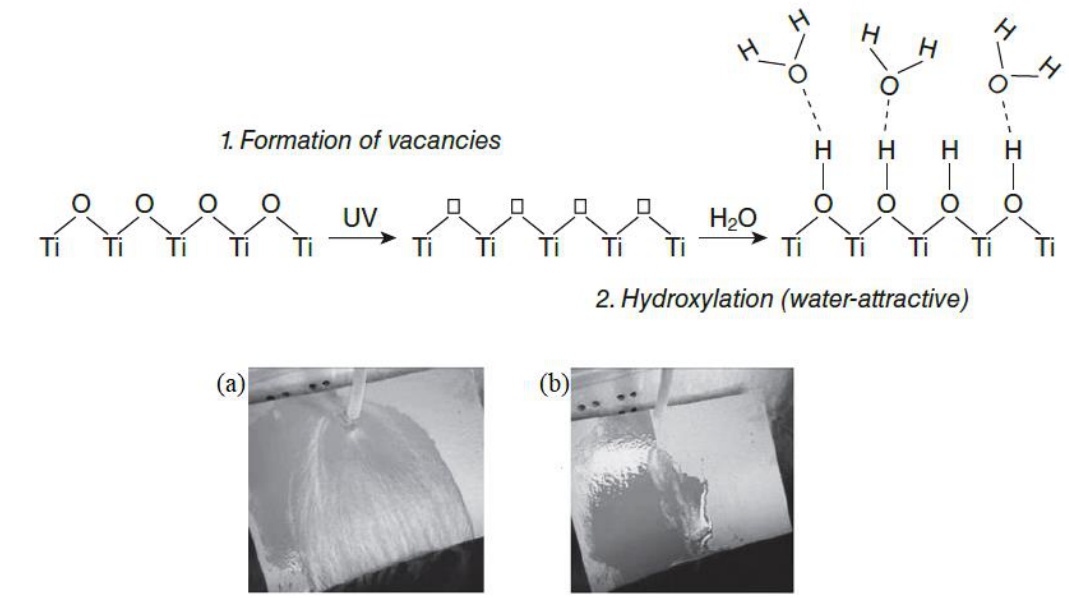
Figure 8. An illustration of the possible photo-induced superhydrophilicity mechanism of TiO 2 and its practical application. The photograph represents a plastic sheet ( a ) covered with TiO 2 , representing the superhydrophilic property, and ( b ) without TiO 2 coating, representing hydrophobic behavior [21].